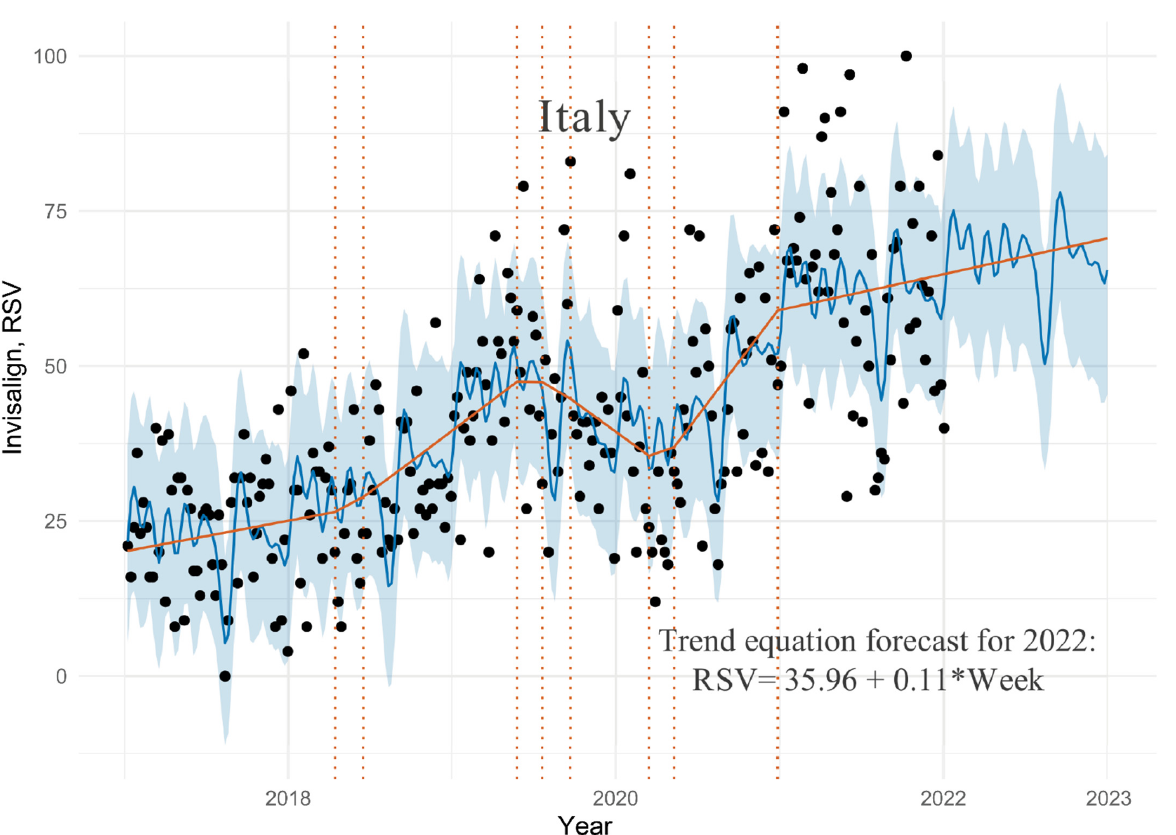
Figure 3. Plot of the distribution of the GT time series for the search results of the keyword “Invisalign” in Italy with the adjustment and prediction by Prophet algorithm and trend equation forecast for 2022, where “Week” is the week number counted from the beginning of dataset (8 January 2017).